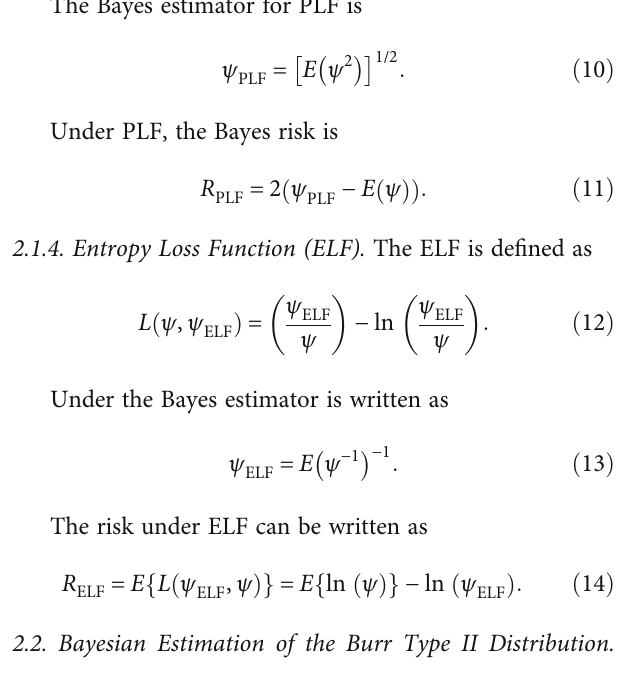
Figure 3: Graph of BEs under di ff erent LFs using NIP for λ = 0 : 1 , using γ = 0 : 5 .